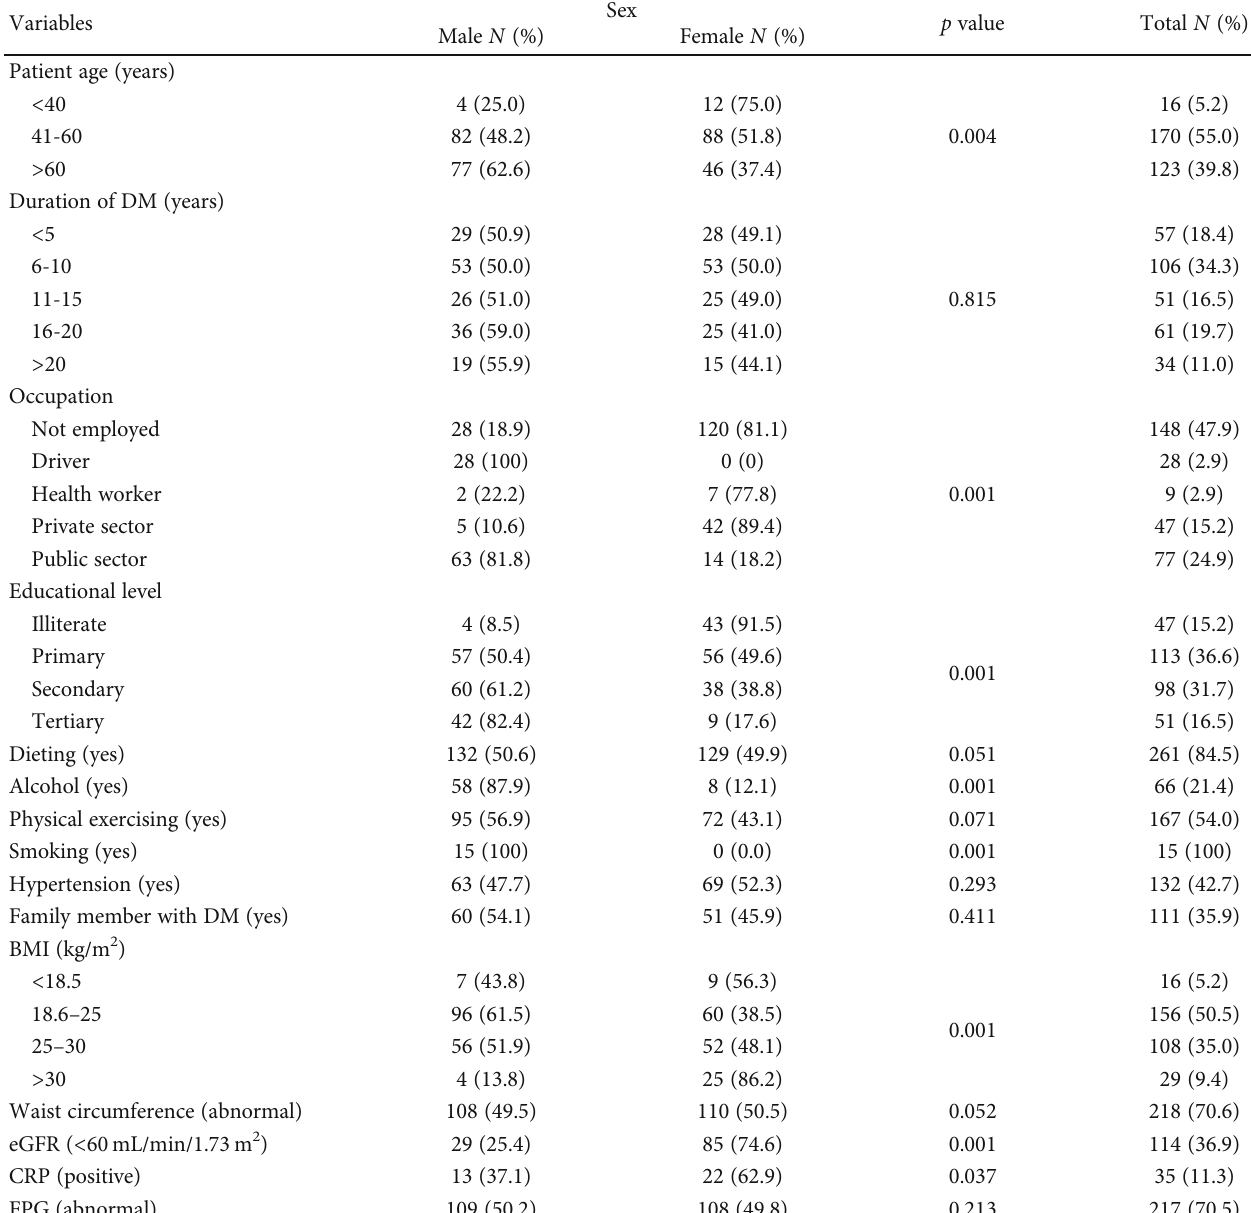
Table 1: Characteristics of the study population strati fi ed by sex